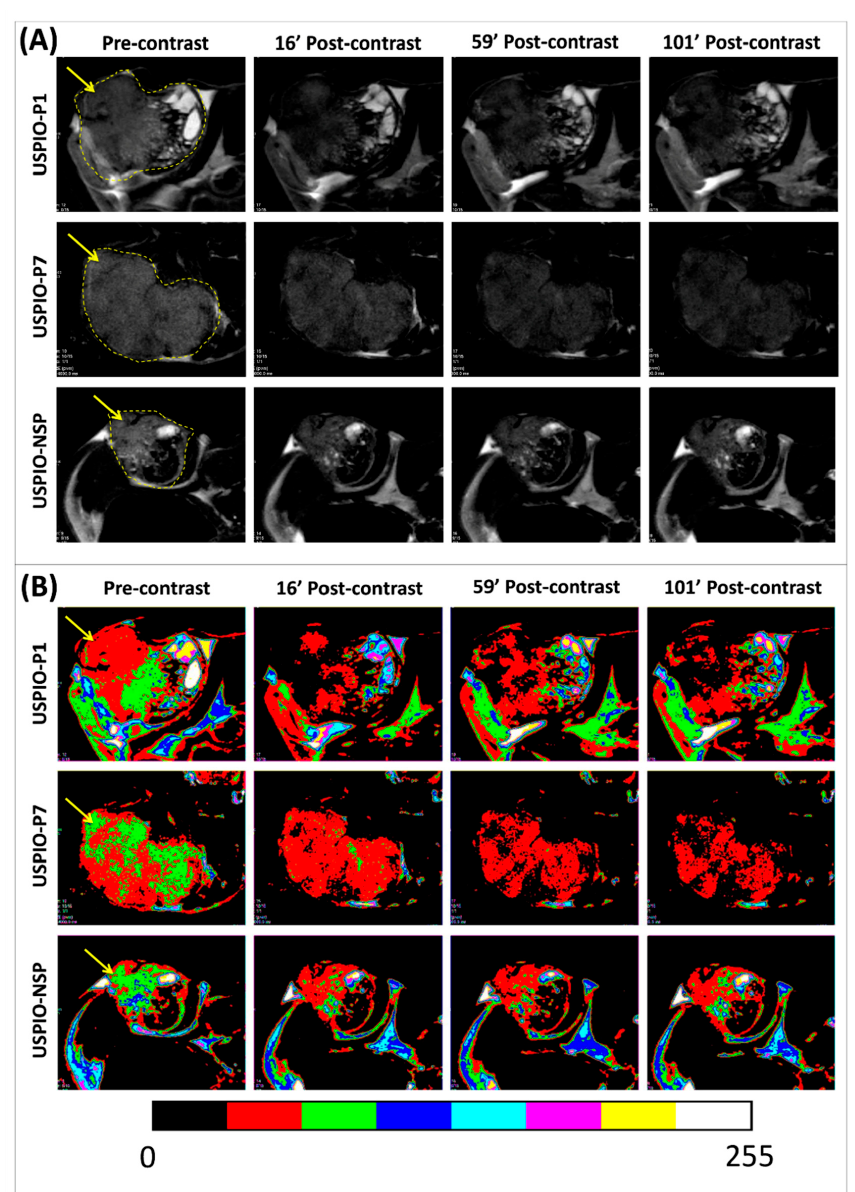
Figure 6. Pre- and post-contrast T 2 -weighted magnetic resonance (MR) images of TPC-1 tumors (pointed by yellow arrows) grafted in athymic nude mice and injected with each one of the USPIO derivatives ( A ). The color masks presented in ( B ) are correlated with the magnitude of negative contrast, observed by the conversion of green or red color in pre-contrast to a red or black color in post-contrast.